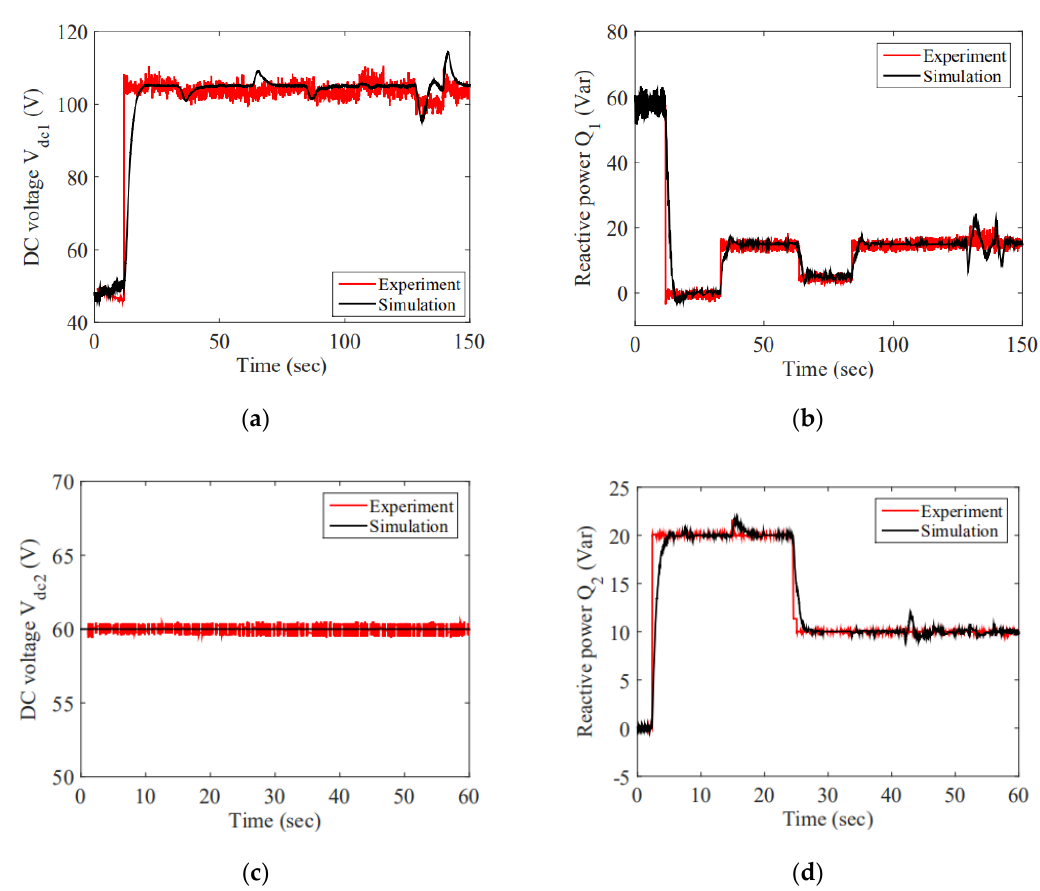
Figure 10. System responses obtained under set point tracking. ( a ) DC voltage V dc1 of rectifier; ( b ) average reactive power Q 1 of rectifier; ( c ) DC voltage V dc2 of inverter; ( d ) average reactive power Q 2 of inverter.